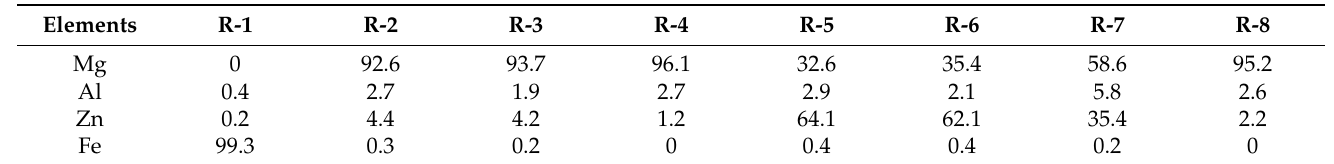
Table 2. Element composition of different regions in Figure 3, in at pct.